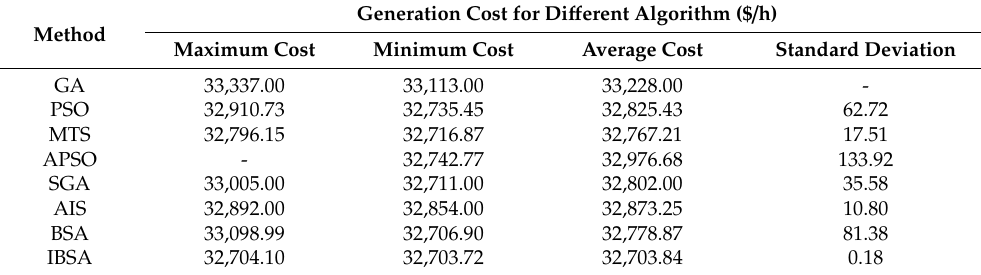
Table 9. Statistical results of multiple methods in System